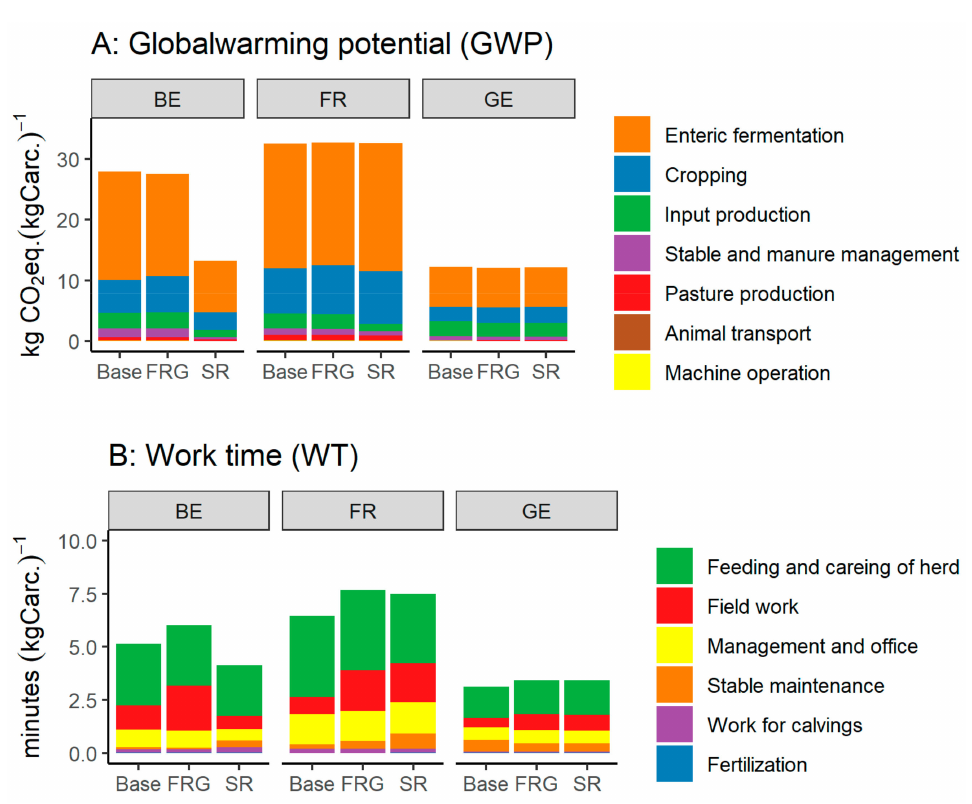
Figure 4. ( A ) GWP per kg of carcass and its different sources for the baseline (Base) and in the fast ro- tational grazing (FRG) and system redesign (SR) scenarios applied to the Belgian (BE), French–Italian (FR-IT), and German (GE) case studies. ( B ) Work time per kg of carcass and its different